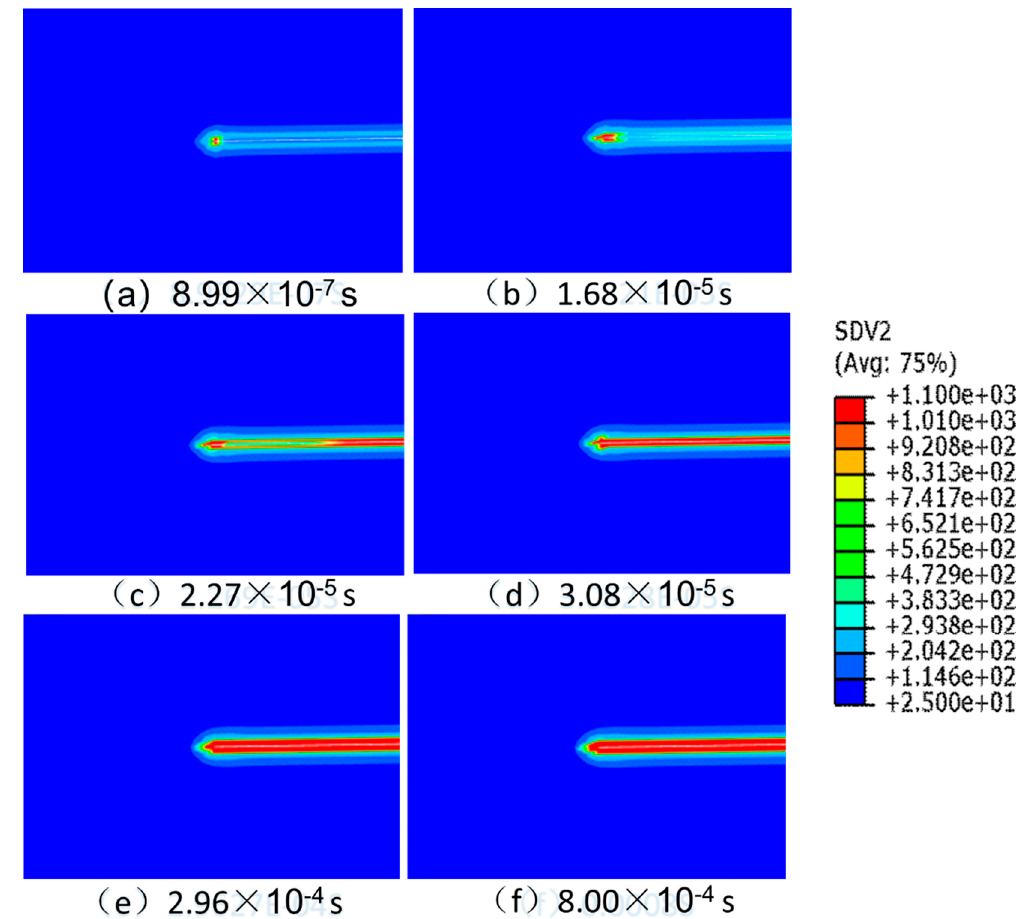
Figure 20. The temperature distribution cloud map of the surface of the composite laminate under the action of 50 kA lightning current at different moments.